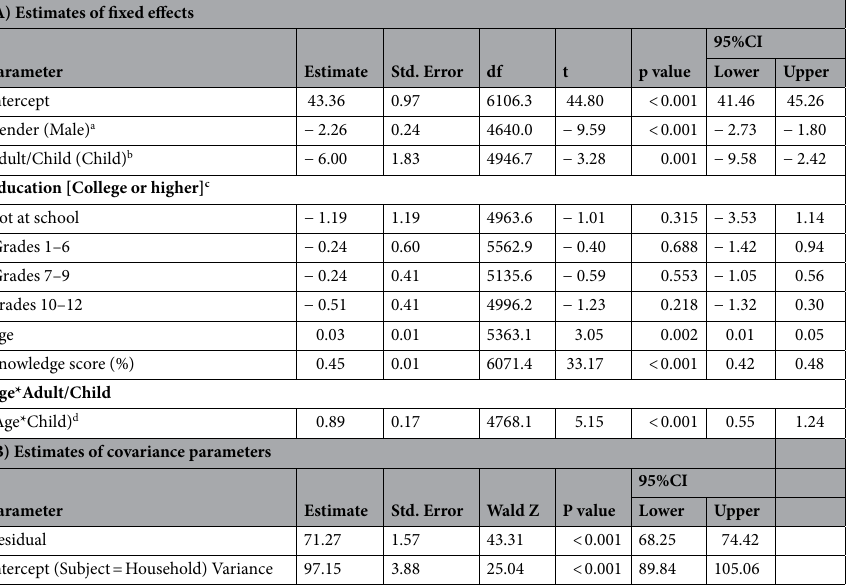
Table 5. Estimates of fixed and random effects for behaviour score (percentage). a Reference group: Females. b Reference group: Adults. c Reference group: College. d Reference group: